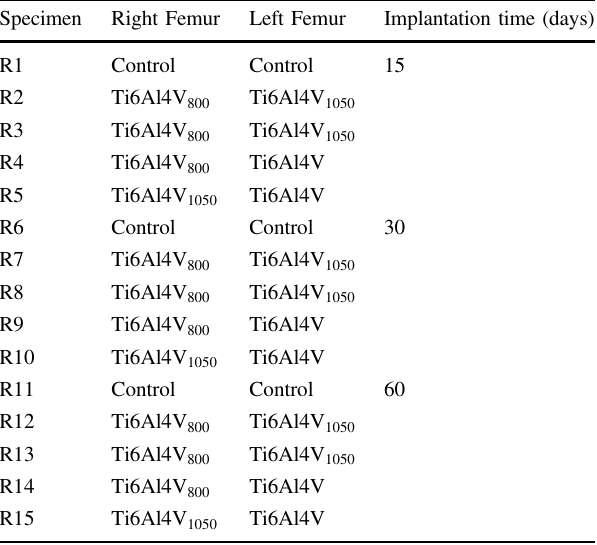
Table 1 Design of experiments of Ti6Al4V, Ti6Al4V 800 , and